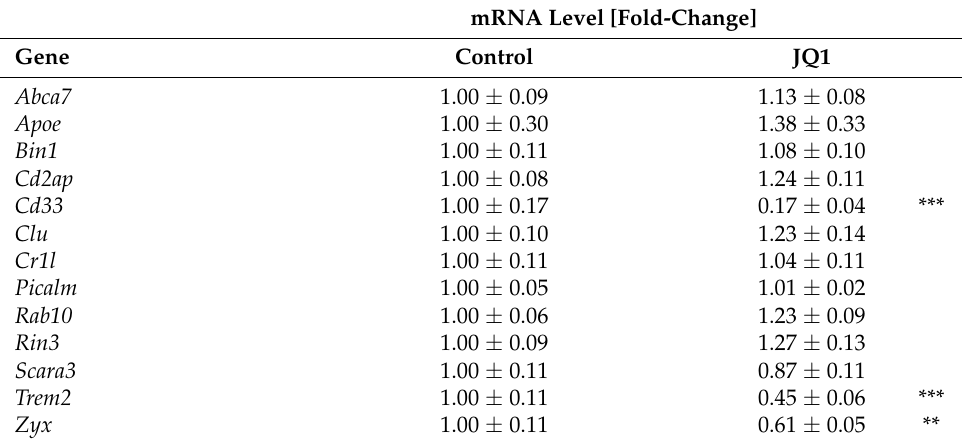
Table 1. The effect of the BET inhibitor on microglial expression of phagocytosis-related AD- involved genes.